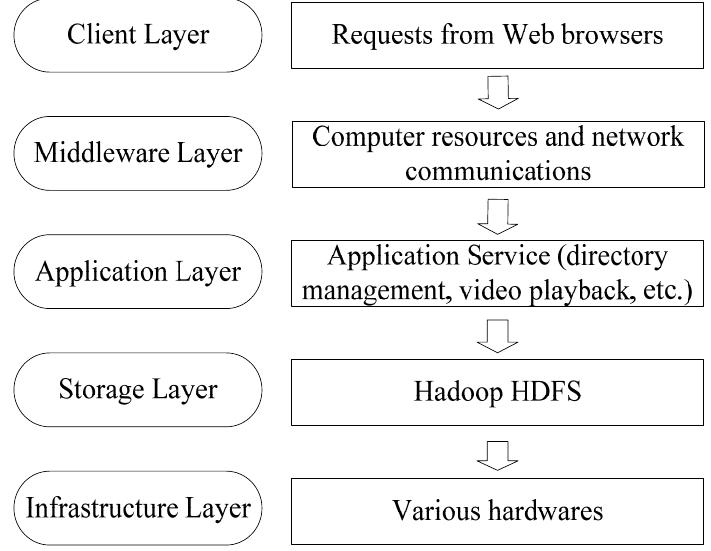
Figure 3. HDFS ‐ based five ‐ layer model for video resource management. Figure 3. HDFS-based five - layer model for video resource management.